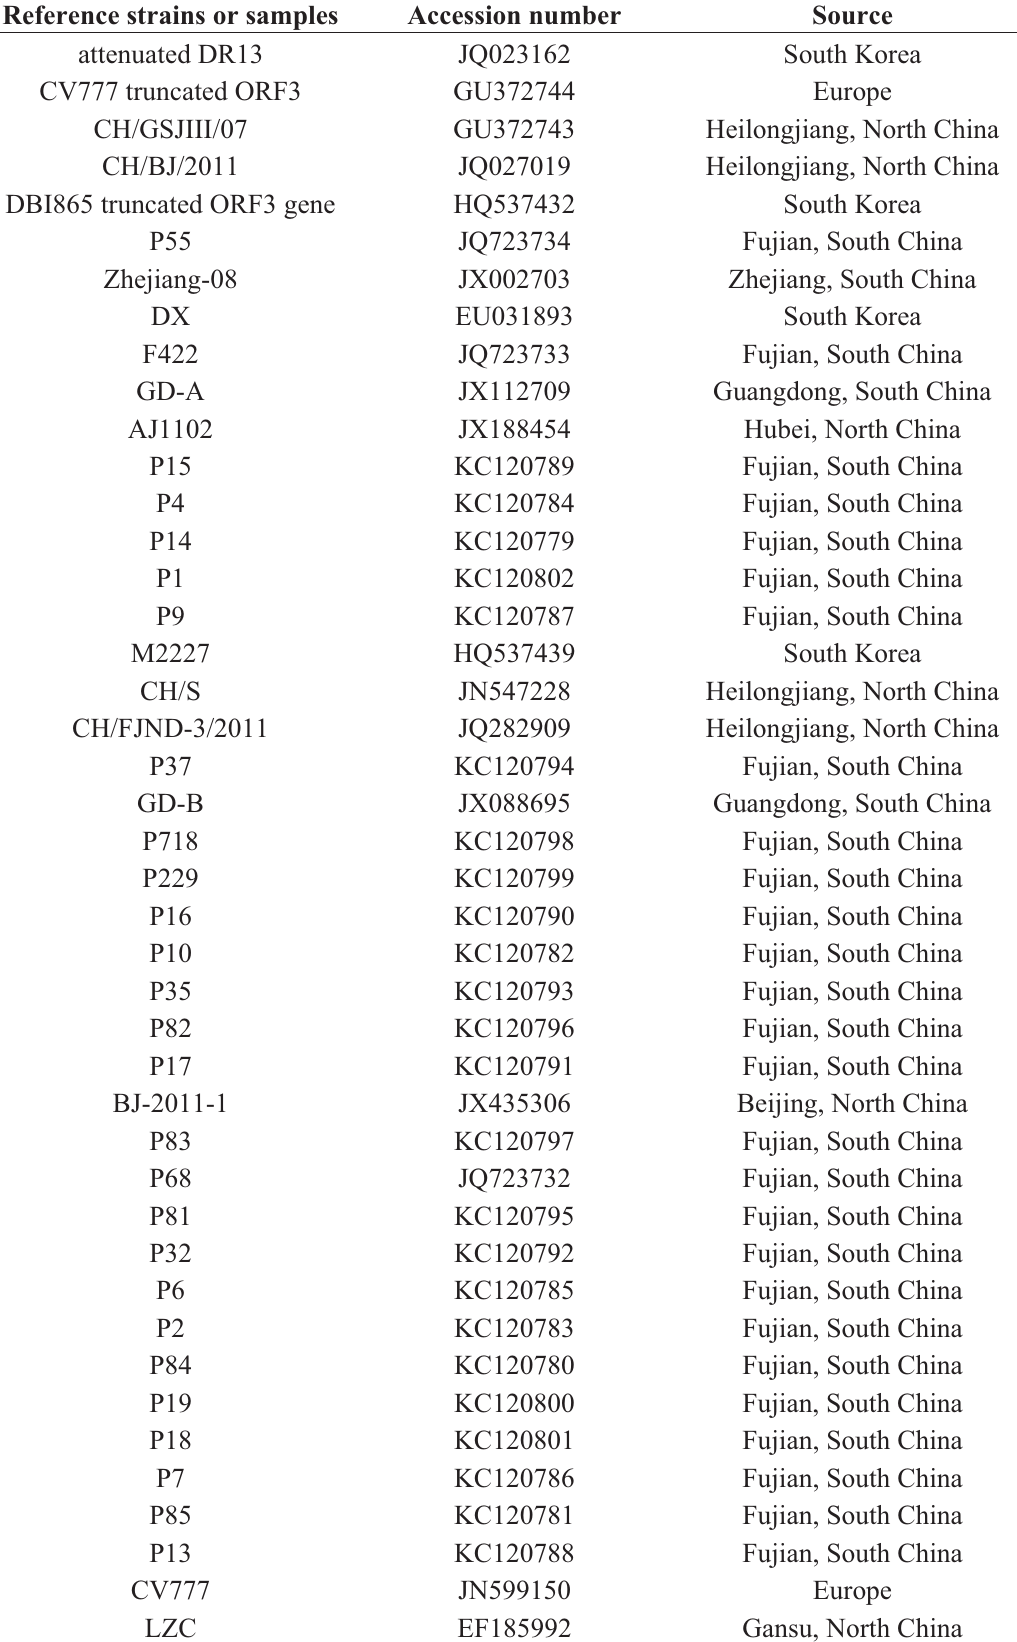
Table 1. Reference porcine epidemic diarrhea virus (PEDV) strains with 99% similarities for the ORF3